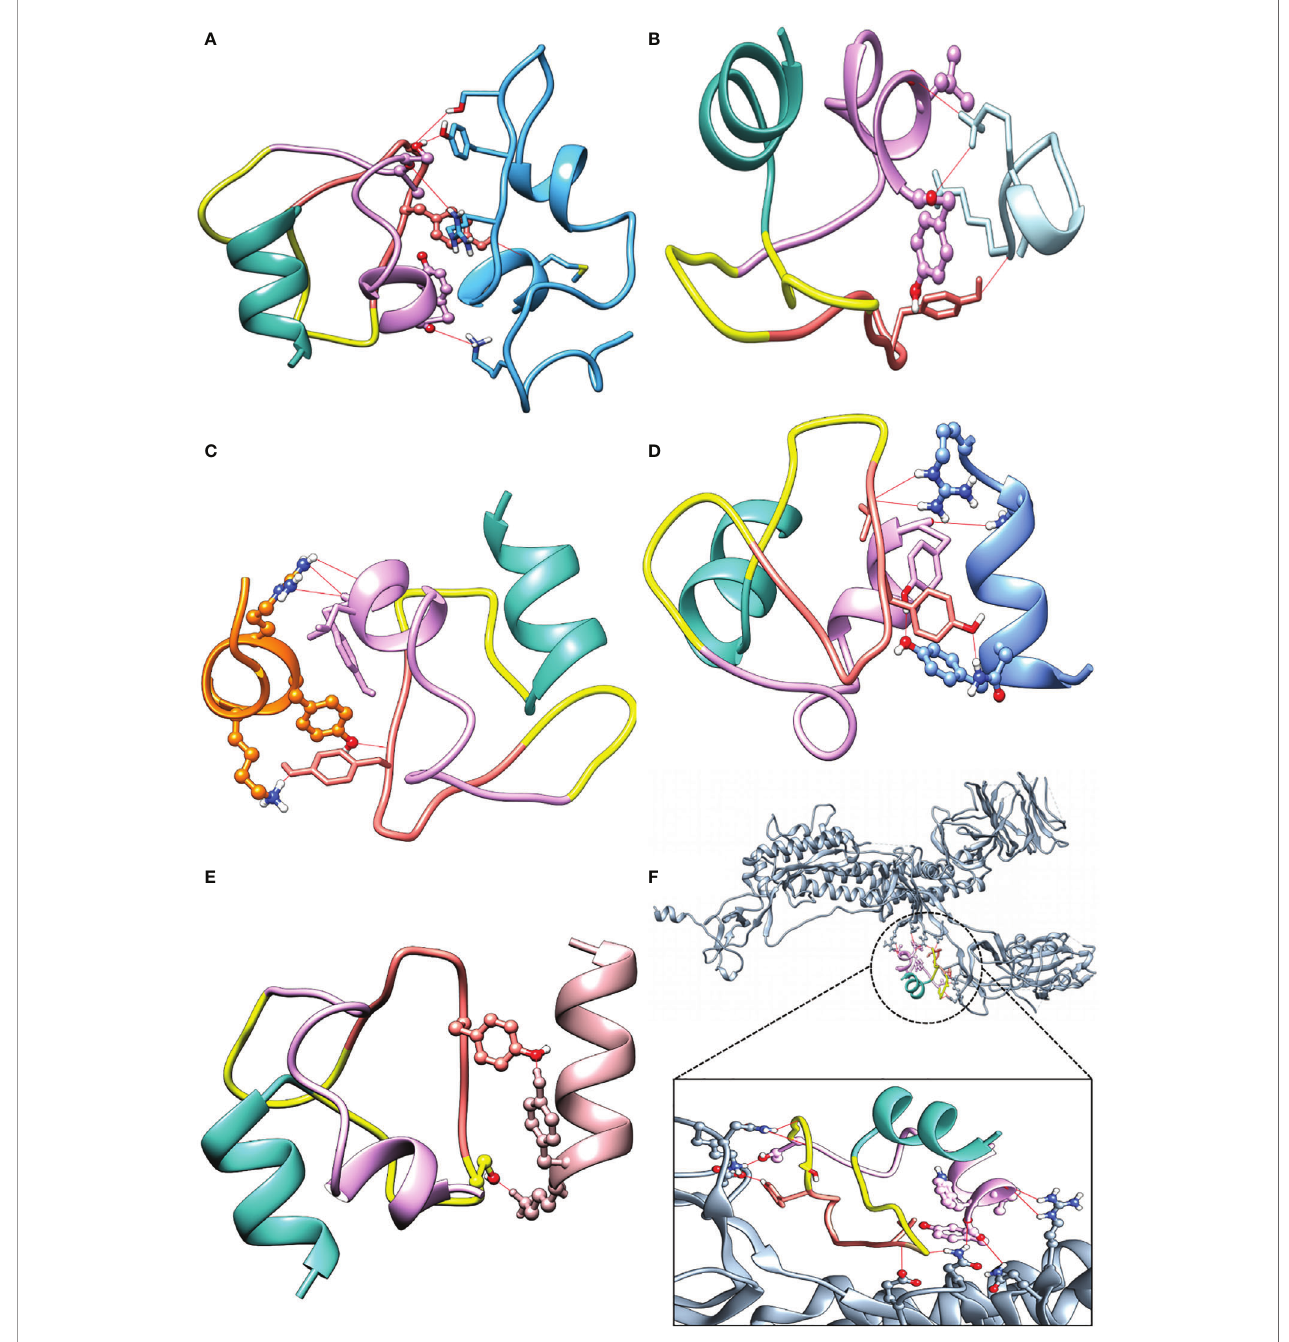
FIGURE 4 | Docking complexes with assembled paratopes (AP) and its respective hydrogen bond numbers. (A) (AP - A26, 5). (B) (AP – SARS-CoV T-cell1, 3). (C) (AP – SARS-CoV T-cell2, 5). (D) (AP – SARS-CoV B-cell1, 5). (E) (AP – SARS-CoV B-cell2, 2). (F) (AP - whole spike, 10). AP color L1 (light sea green), L2 (Plum), H (salmon), and Linker